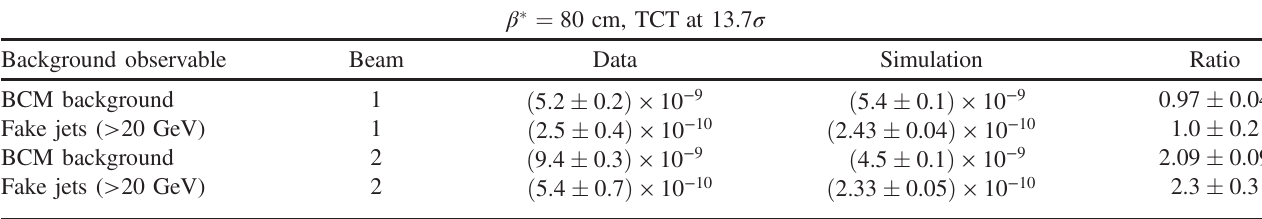
TABLE VII. Comparison of measured background rates with simulations, normalized to the number of protons lost from the bunch. The data for the BCM background are the same as in Table II. The errors are statistical only. The ATLAS data and simulations are taken from Ref. [24], but the simulation results have been rescaled to the most recent SIXTRACK results in Table V. β (cid:1) ¼ 80 cm, TCT at 13 . 7 σ